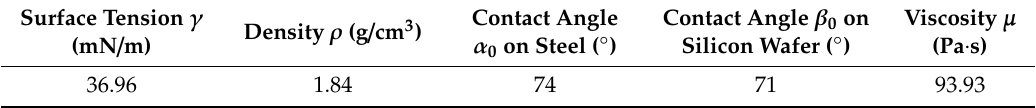
Table 1. Properties of the adhesive.